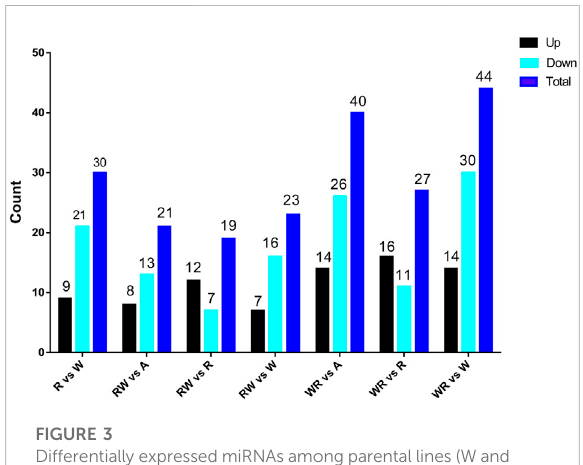
FIGURE 3 Differentially expressed miRNAs among parental lines (W and R),hybrids(WRandRW)andsynthesizedaverageexpressionofthe parents